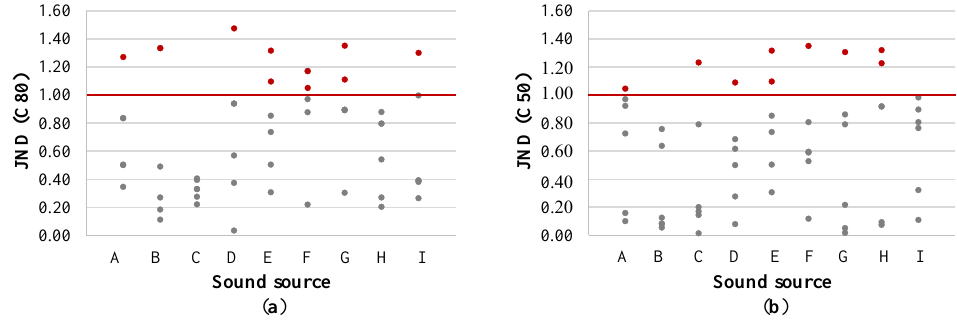
Figure 8. ( a ) Just noticeable difference of C80 (CATT-Acoustic simulation). ( b ) Just noticeable difference of C50 (CATT-Acoustic simulation).